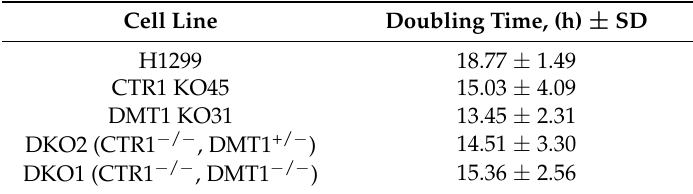
Table 2. Doubling time of H1299-derive clones.